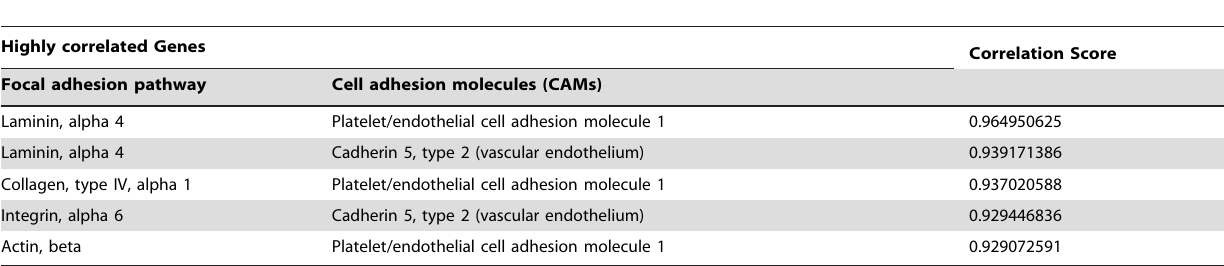
Table 10. Sample correlation scores of highly correlated genes (Focal adhesion and Cell adhesion molecules pathways).